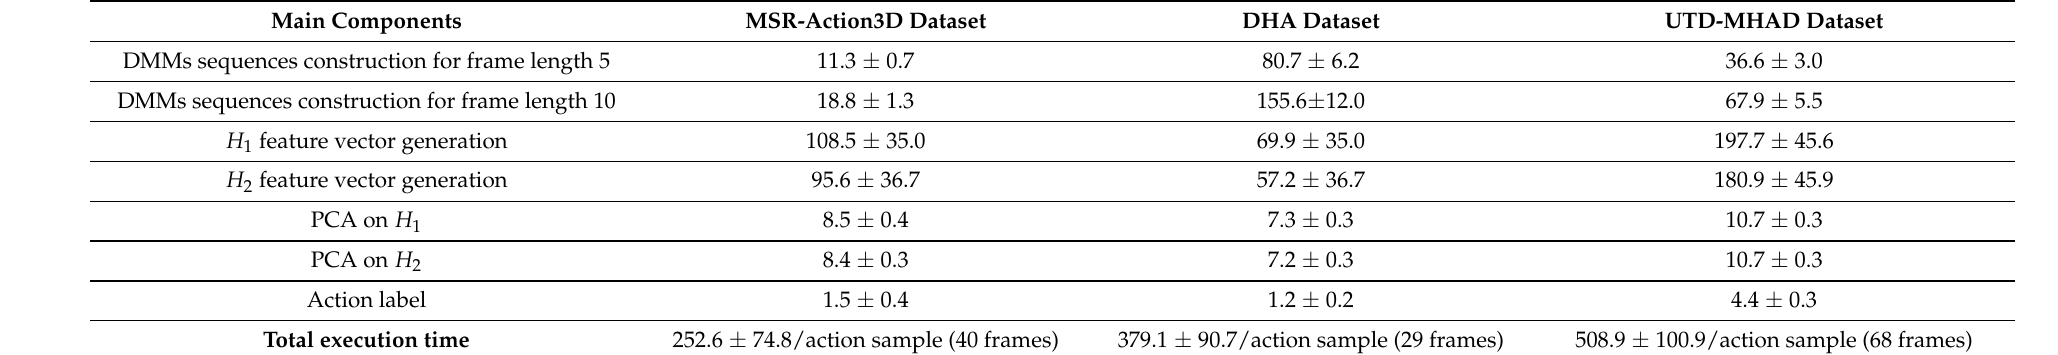
Table 7. Comparison of execution time (mean ± std) of the key factors on three datasets.